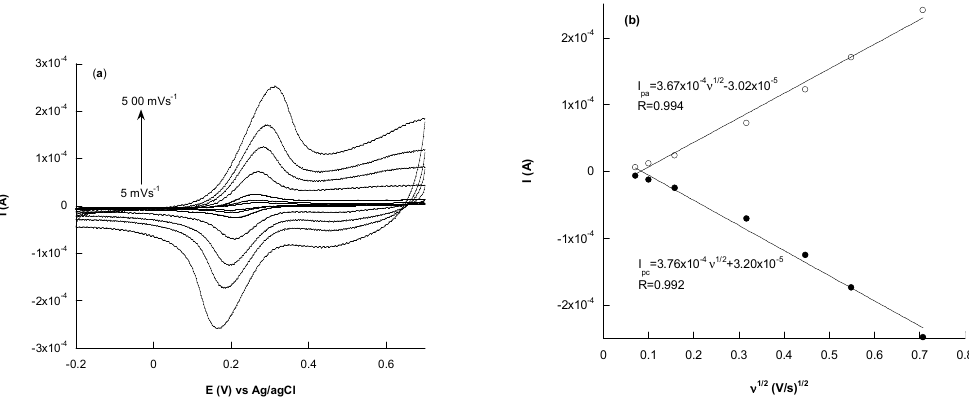
Figure 4. CVs ( a ) of h-nPG electrode at different scan rates (5, 10, 25, 100, 200, 300, 500 mVs − 1 ) and ( b ) the corresponding peak currents vs. the square root of scan rate in 5 mM [Fe(CN) 6 ] 3 − /4 − and 0.1 M KCl.